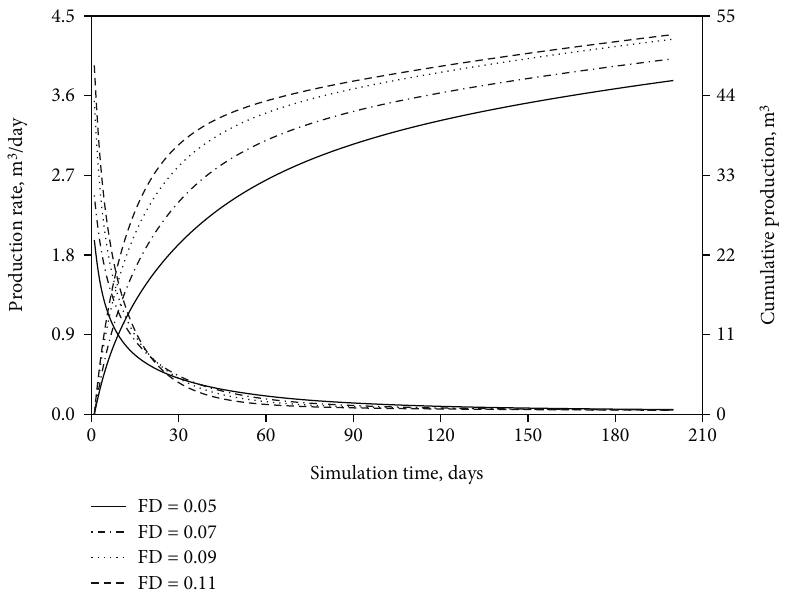
Figure 4: Comparison of well performances of the four models with di ff erent fracture